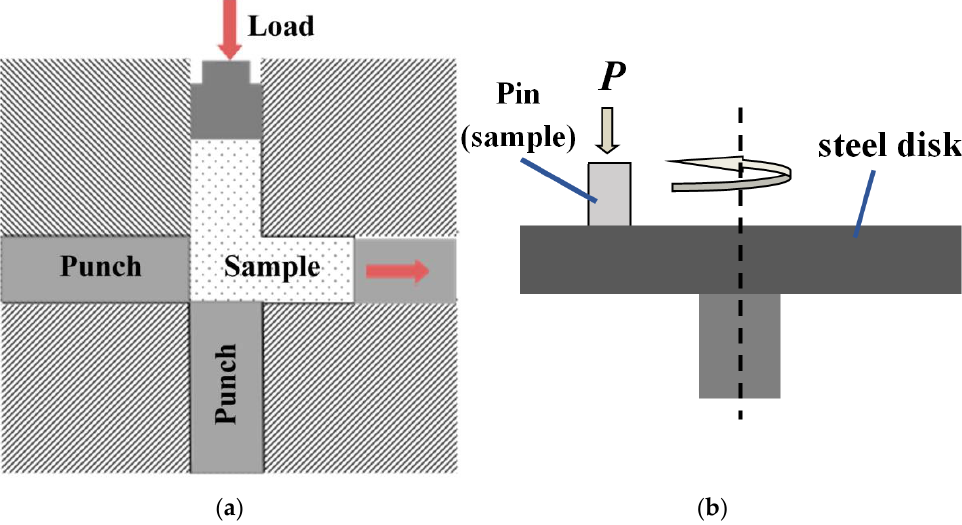
Figure 1. Sample processing scheme in the die for ECAP ( a ) and scheme pin-on-disk of the wear tests ( b